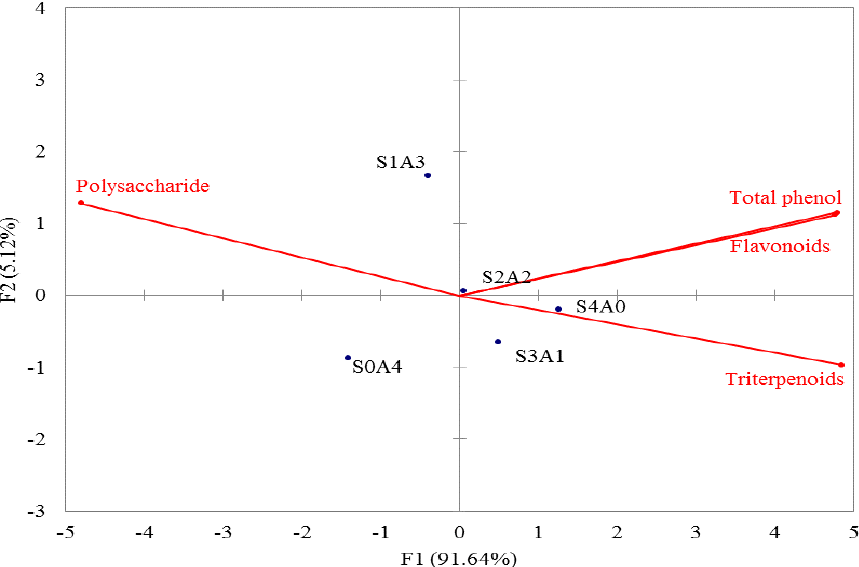
Figure 1. Principal component analysis (PCA) of the effects of different media on mycelial products obtained by white truffle solid-state fermentation. Data are expressed as mean ± S.D. ( n = 3). S: soybean, A: red bean, A: red adlay.